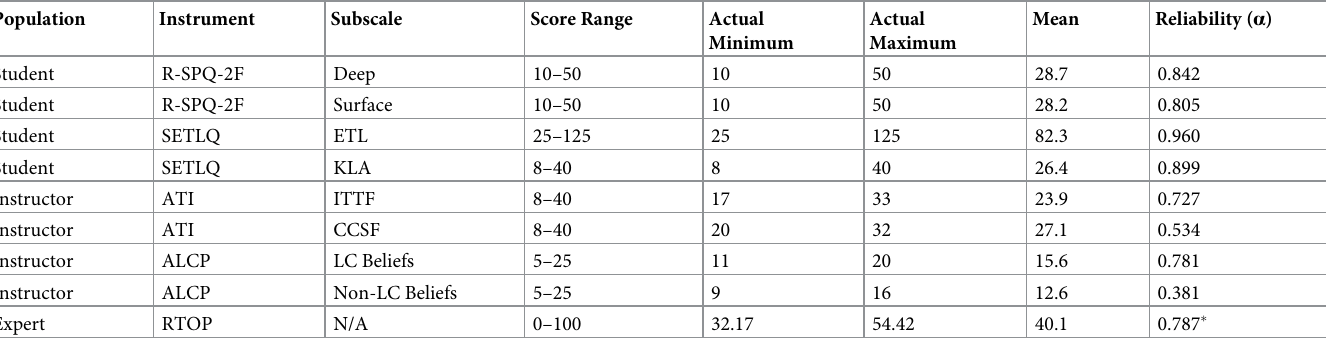
Table 3. Summary statistics for student, instructor, and expert observer instruments.